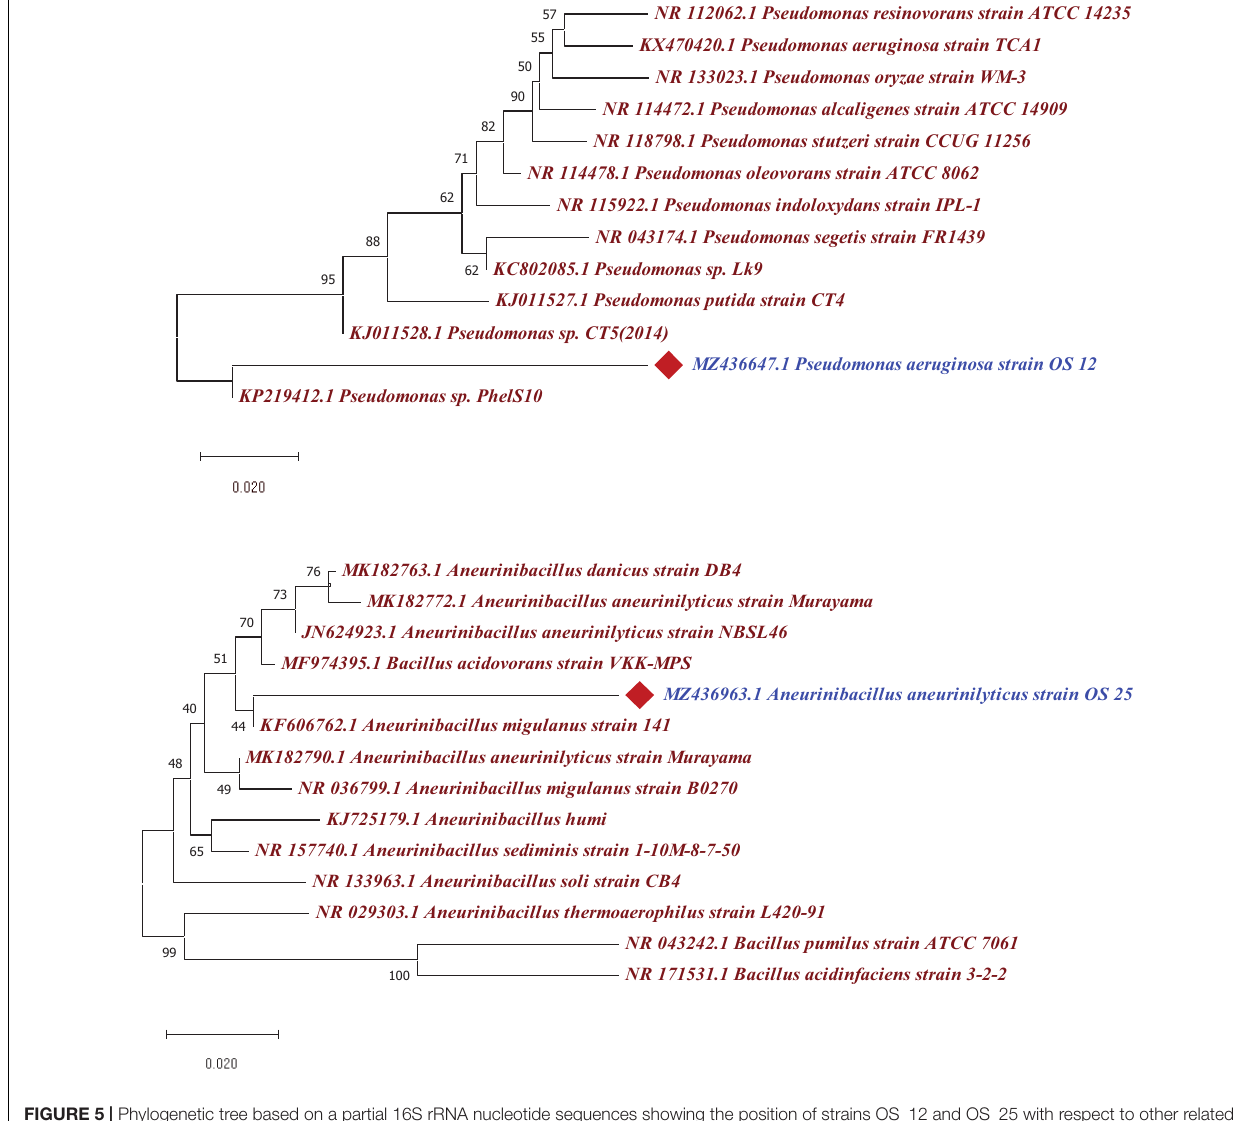
FIGURE 5 | Phylogenetic tree based on a partial 16S rRNA nucleotide sequences showing the position of strains OS_12 and OS_25 with respect to other related taxa constructed with Neighbor joining method using version 10.1 of MEGA software (https://www.megasoftware.net/). The 16S rRNA gene sequences of closely related species were retrieved from NCBI GenBank databases. Evolutionary distance was computed using Maximum Composite Likelihood method. Bootstrap values (percentage of 1,000 replicates) higher than 40% are shown at node points. Bar, 0.020 substitutions per nucleotide